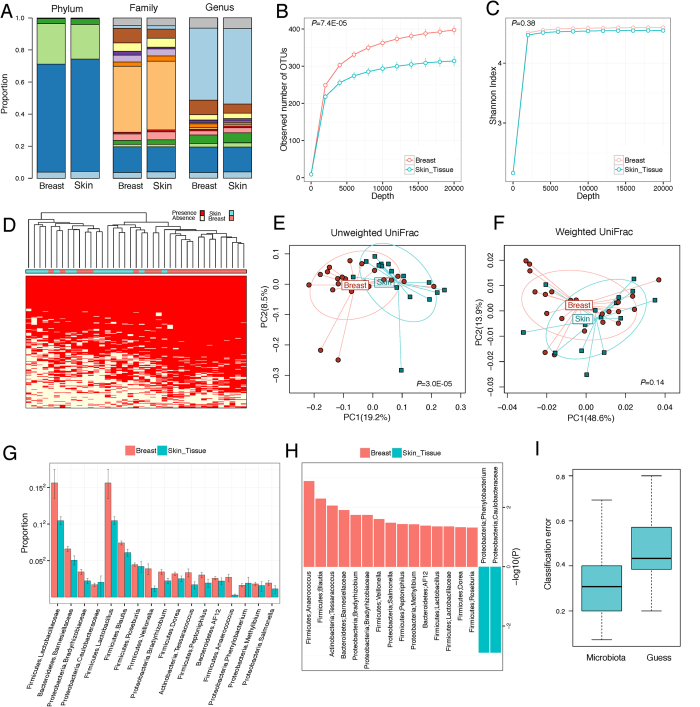
The microbiota of breast tissue is distinct from skin tissue in rare bacterial lineages.(A) Barplots of the taxonomic profiles of the breast and skin tissue microbiota at phylum, family and genus level for taxa with a relative abundance >0.5%. (B,C) Rarefaction curves compare the two alpha-diversity measures (observed OTU number (B) and Shannon index (C)) between the two tissue types. (D) Heat map shows the OTU presence and absence of all the tissue samples (column: samples, row: OTUs). The hierarchical clustering (top) is built based on the Euclidean distance of the OTU presence/absence profiles with a complete linkage. (E,F) Ordination plots show the clustering pattern of the two tissue samples based on unweighted (E) and weighted (F) UniFrac distance. (G,H) Differential taxa between breast and skin tissue microbiota based on a permutation test. Taxa with a nominal p value < 0.05 at the family and genus level are shown with their mean abundances in each tissue type (G) and their significance (H). Error bars represent standard error of the mean. (I) Boxplot compares classification error between a microbiota-based predictor (Left: Microbiota) and a predictor solely based on the majority class in the training set (Right: Guess). Random forest based on genus-level abundance is used to build the predictive model and 100 bootstrap samples are used for assessing the classification error.